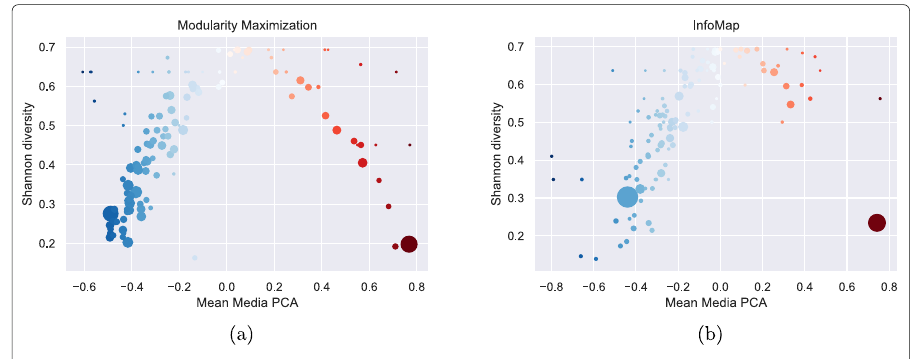
Fig. 4 Shannon diversity index for communities from ( a ) modularity maximization and ( b ) InfoMap. The disk sizes correspond to the number of nodes in the communities. More extreme mean media PCA scores are associated with lower diversity in a community, and the larger communities tend to have smaller Shannon diversities and more polarized media